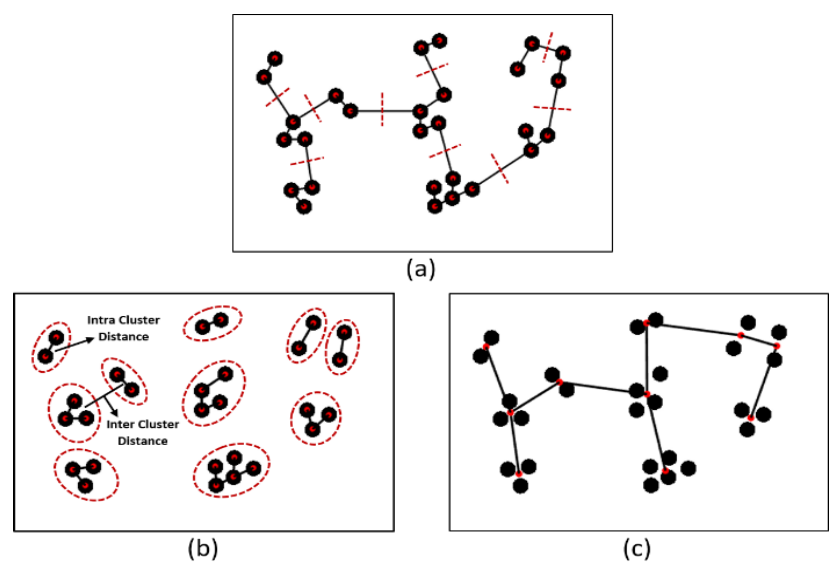
Figure 6. Examples of MST cluster analysis. ( a ) An MST is based on the minimum distances between vertex coordinates. The red dashed lines indicate the removal of inconsistent edges. ( b ) An intra- cluster MST was obtained after removal of the nine longest edges from ( a ); the red circles indicate inter- and intra-cluster similarity. ( c ) The inter-cluster MST was obtained from ( b ).